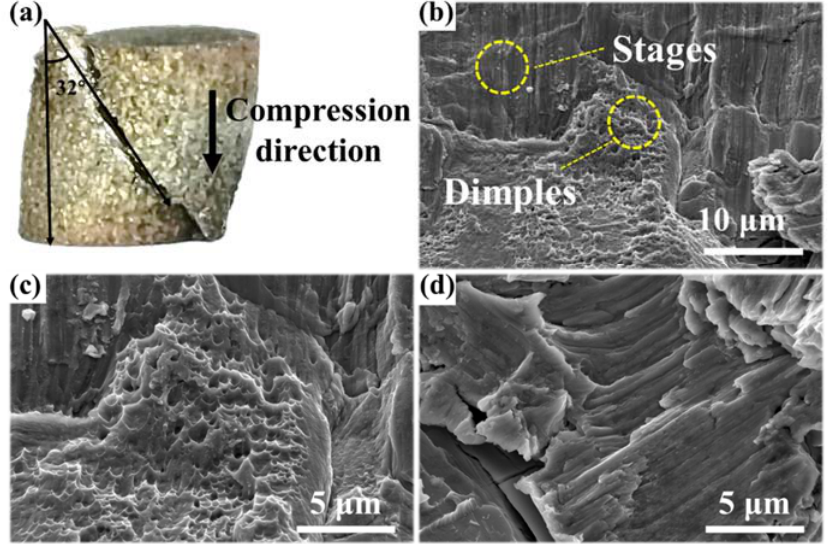
Figure 6. Fractured specimen after quasi ‐ static compression. ( a ) Macro ‐ feature image. ( b ) SEM im ‐ ages of micro ‐ fracture surface of Ce5. ( c ) Dimples and ( d ) stages under quasi ‐ static compression.